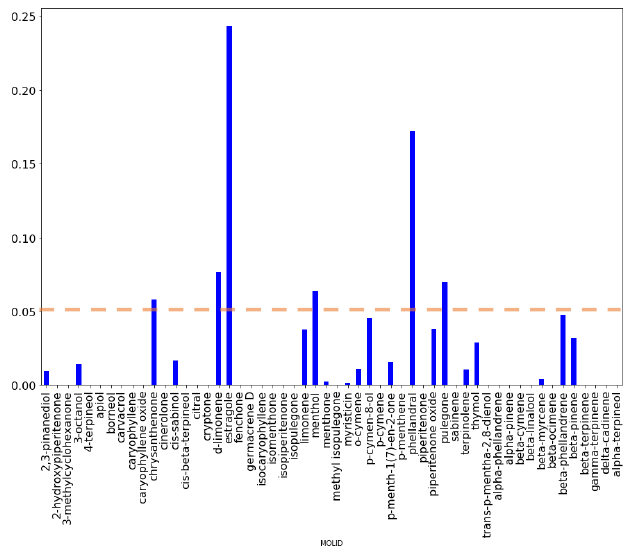
Figure 3. Feature importance plot obtained for the GB classification models at 48.8 g/mL.